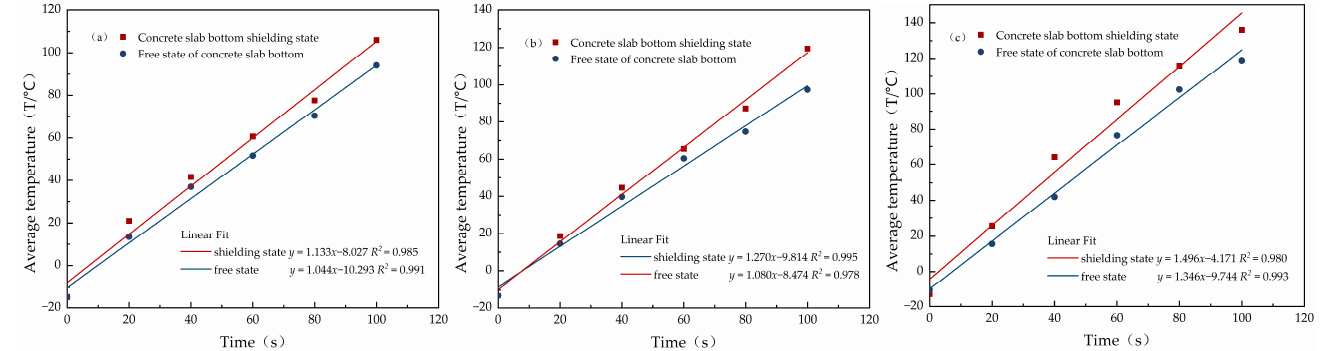
Figure 13. Linear fit of the mean value of the surface temperature for concrete slabs with different magnetite contents at different levels of power in the free state and with and bottom shielding: ( a ) 4000 W and 80 vol %; ( b ) 7000 W and 60 vol %; ( c ) 10,000 W and 60 vol %.